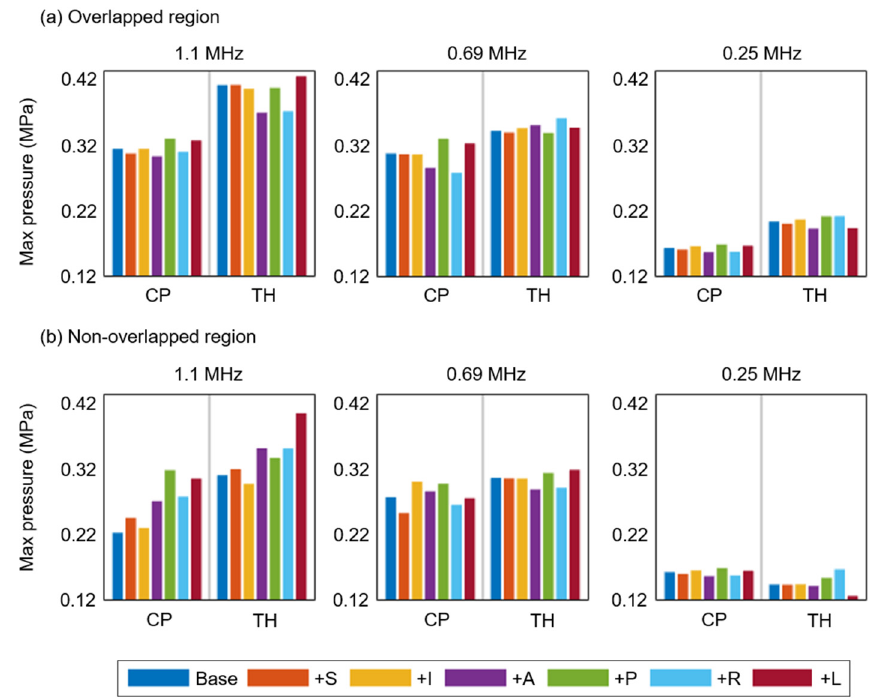
Figure 5. Effects of transducer displacement on intracranial maximum pressure in the overlapped ( a ) and non-overlapped ( b ) focal volumes compared with the base model at 1.1, 0.69, and 0.25 MHz. The transducer was displaced by 0.5 mm in all six directions—+S, +I, +A, +P, +L, and +R—relative to its base location.